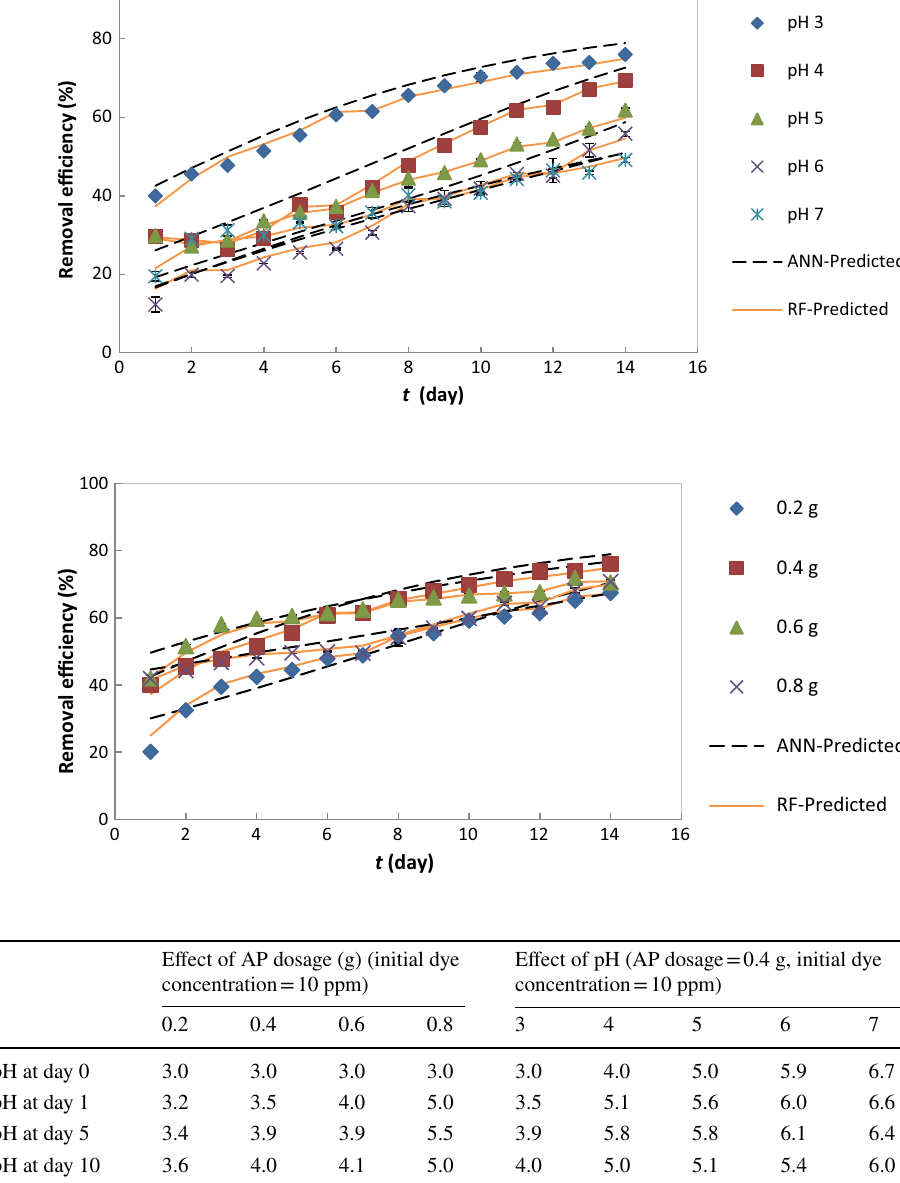
Table 2 pH of dye solutions before and after phytoextraction process using